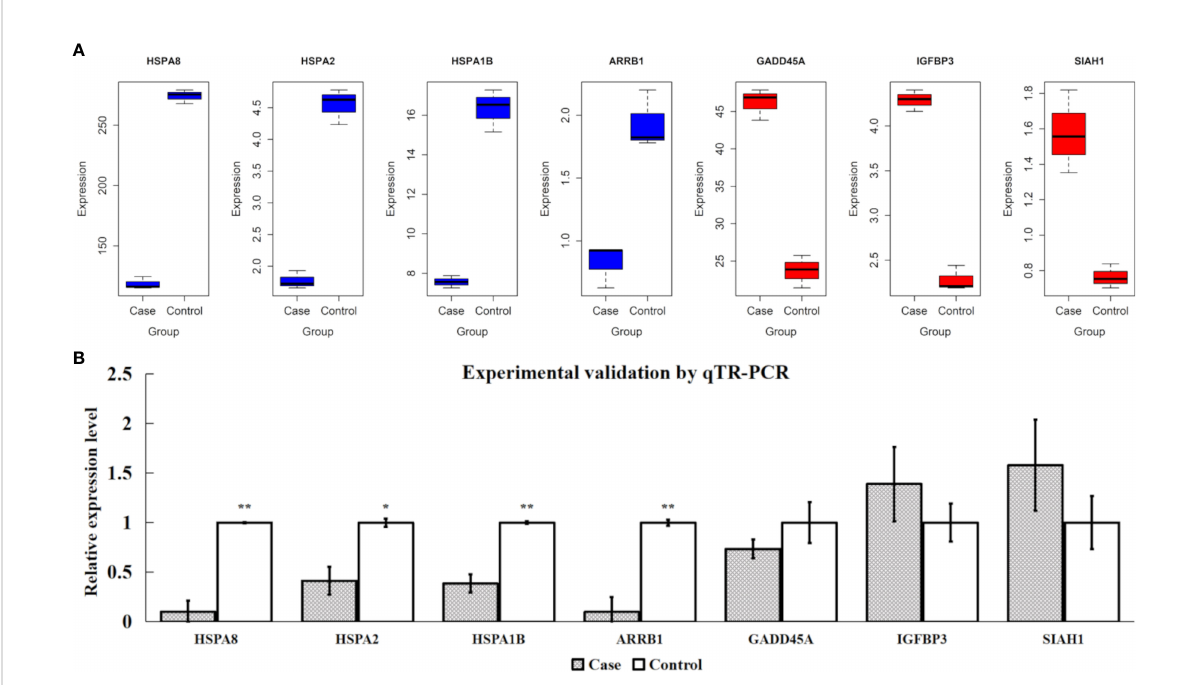
FIGURE 7 Validations for four extremely downregulated differentially expressed (DE) genes ( HSPA8 , HSPA2 , HSPA1B , and ARRB1 ) and three extremely upregulated DE genes ( GADD45A , IGFBP3 , and SIAH1 ). (A) Gene expression of FPKM values, where the blue and red colors indicate the downregulated and upregulated genes, respectively. (B) Experimental validations by qTR-PCR. ** and * indicate P -value <0.01 and P -value <0.05, respectively, after Student ’ s t